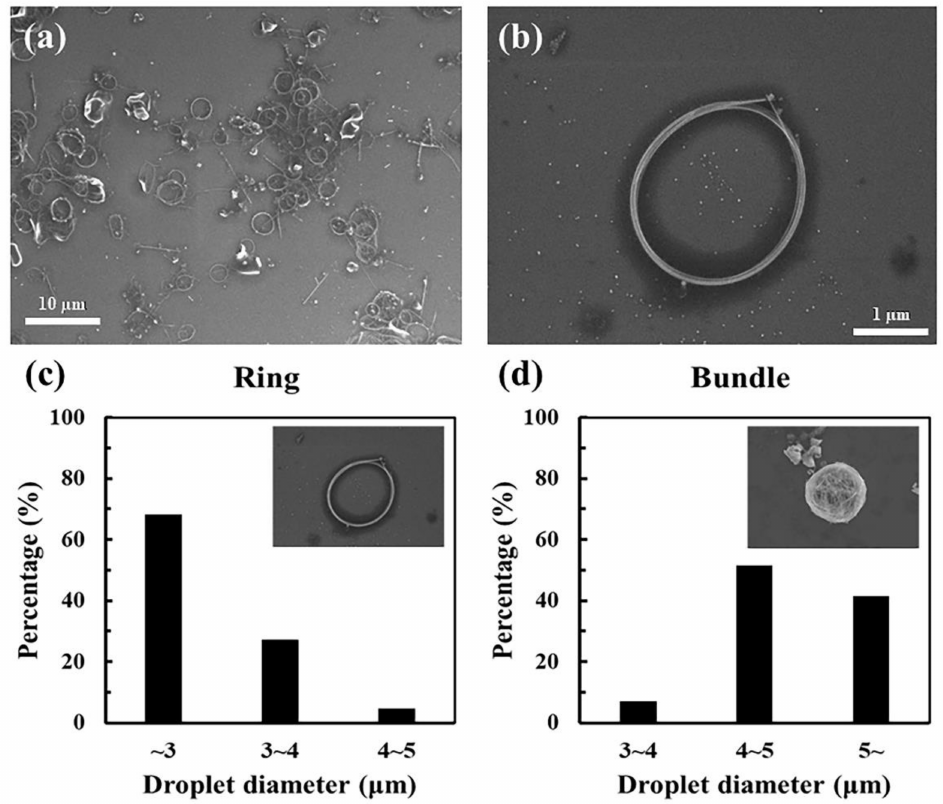
Figure 2. ( a , b ) SEM images of coiled silver nanowires, ( c ) droplet diameters of a single Ag nanowire, and ( d ) droplet diameters of entangled Ag